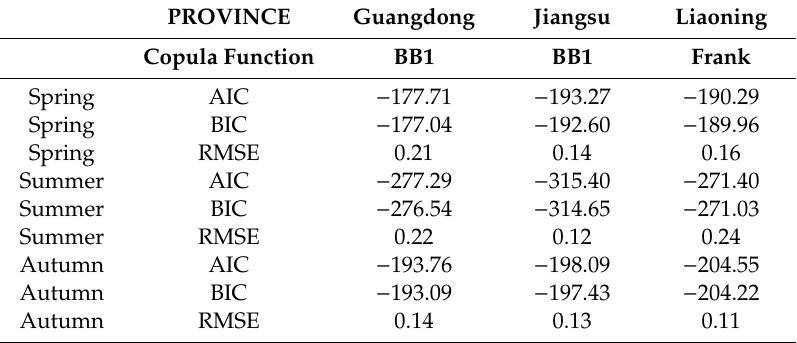
Table 5. Copula function cluster selection criteria for Tmin–NDVI in Guangdong, Jiangsu and Liaoning.